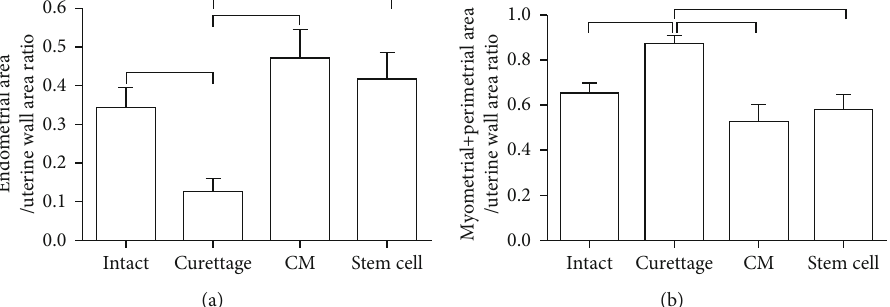
Figure 7: Mean and standard error of the uterine histomorphometric indices to compare the preventive e ff ects of intrauterine bone marrow- derived mesenchymal stromal cell- (BM-MSC-) conditioned media (CM) injection on uterine fi brosis after endometrial curettage in rabbit. (a) Endometrial area/uterine wall area ratio. (b) Myometrial + perimetrial area/uterine wall area ratio. The horizontal line above the columns show a statistically signi fi cant di ff erence ( P < 0 : 05